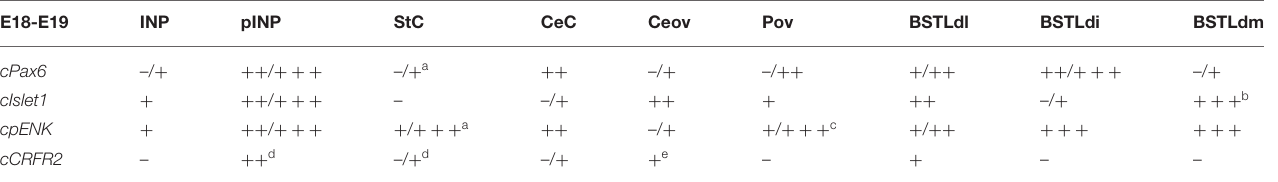
Figure 8. Expression of cpENK , cCRFR2 , cSOM, and cTH in the central extended amygdala of chicken embryos at intermediate or late stages. (A–F) Digital images of frontal sections of the telencephalon of chicken embryos (from E14 to E19), hybridized for the phenotype markers cpENK , cCRFR2